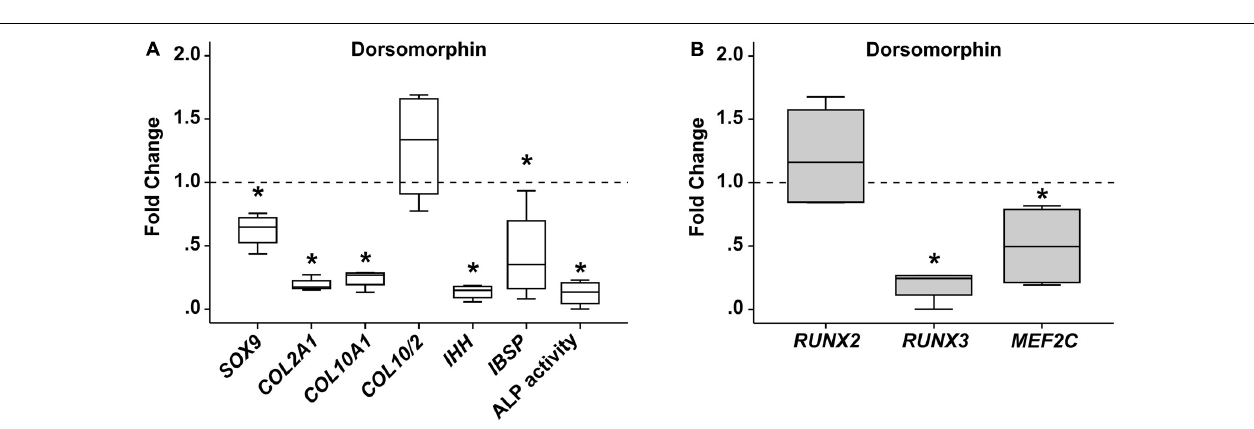
FIGURE 5 | Effects of BMP-receptor inhibition on RUNX2, RUNX3, and MEF2C. MPC pellets were subjected to chondrogenic induction for 2 weeks before treatment with 10 µ M dorsomorphin or 0.1% DMSO until week 6 ( n = 4 donors). Expression of indicated genes was determined by qPCR (A,B) , and levels were referred to reference genes HNRPH1 and CPSF6 . ALP activity was quantified in culture supernatants (A) . Expression levels of indicated genes and ALP activity are referred to DMSO cultures (dashed lines). Box plots were generated as described in Figure 1 . *, p ≤ 0.05, Mann–Whitney U test compared to